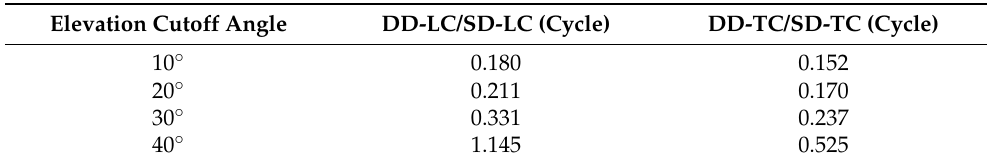
Table 3. The mean ADOP values of the DD-LC, DD-TC, SD-LC, and SD-TC models under different elevation cutoff angles in the single-epoch solution.